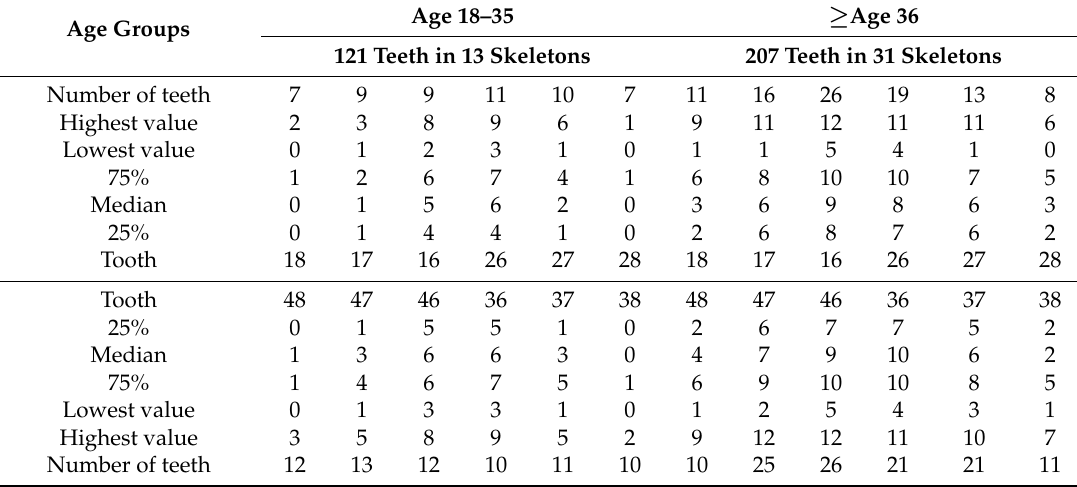
Table 4. Tooth wear in 18–35 years and 36 years and older according to Brothwell.